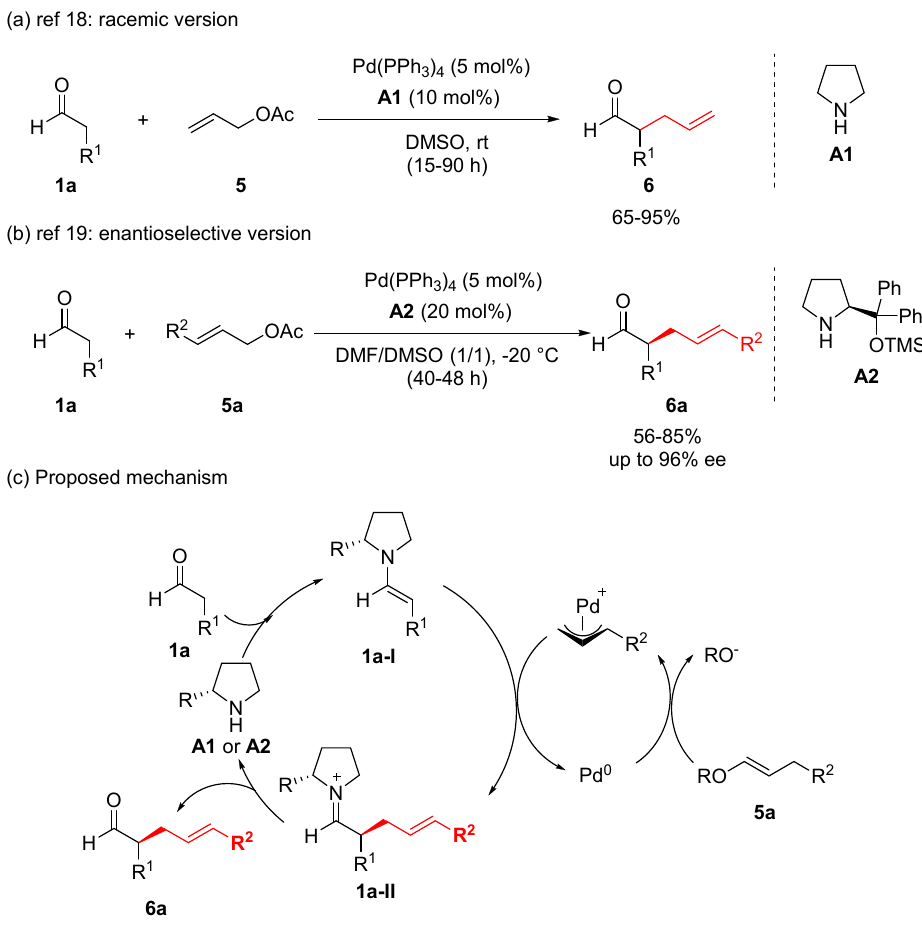
Scheme 4. ( a ) Racemic version of palladium- and pyrrolidine-catalyzed α -allylic alkylations